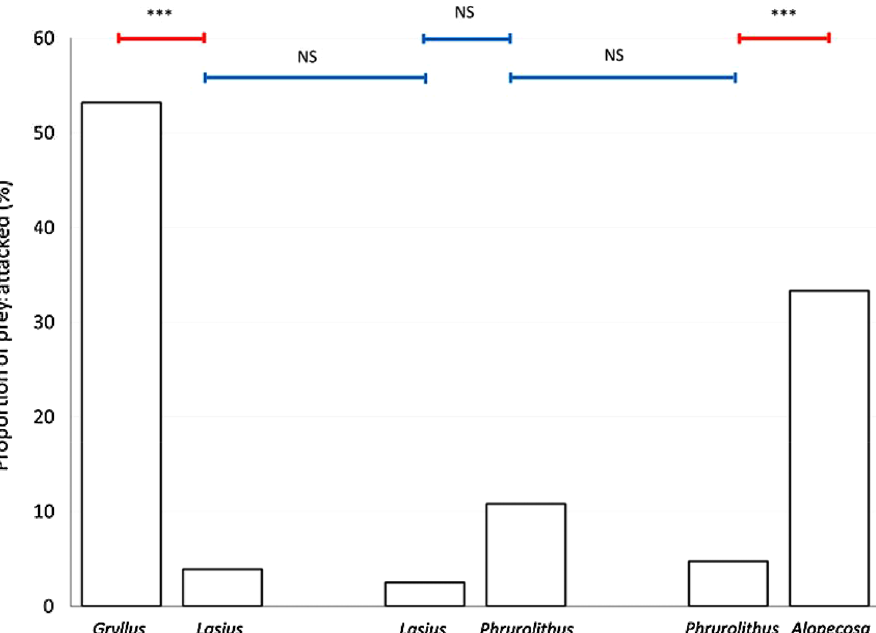
Figure 3. The proportion of attacked offered prey in particular prey pairs. Gryllus —Mediterranean cricket ( Gryllus bimaculatus ), Lasius —black garden ant ( Lasius niger ), Phrurolithus —myrmecomorph spider